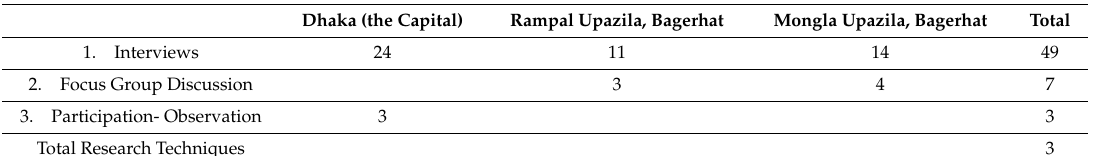
Table 1. Sources for Gathering the Primary